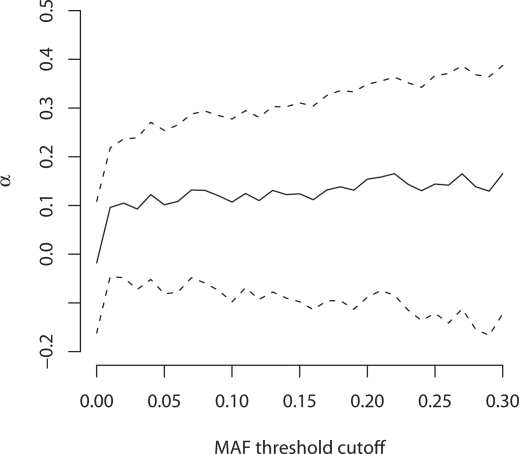
Fraction of adaptive substitutions (α) in primate pCRMs and ChIP-chip sequences versus the threshold minor allele frequency (MAF) that was excluded from the analysis prior to the estimation of α (see text).Confidence intervals are shown as dashed lines and were estimated by bootstrapping the data by case-control region, 10000 times.